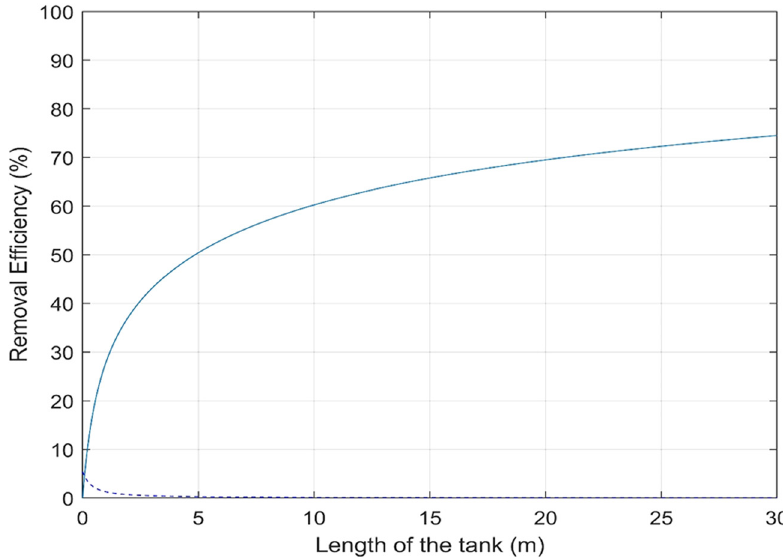
Figure 4: Accumulative removal e ffi ciency without fl occulation process for coded